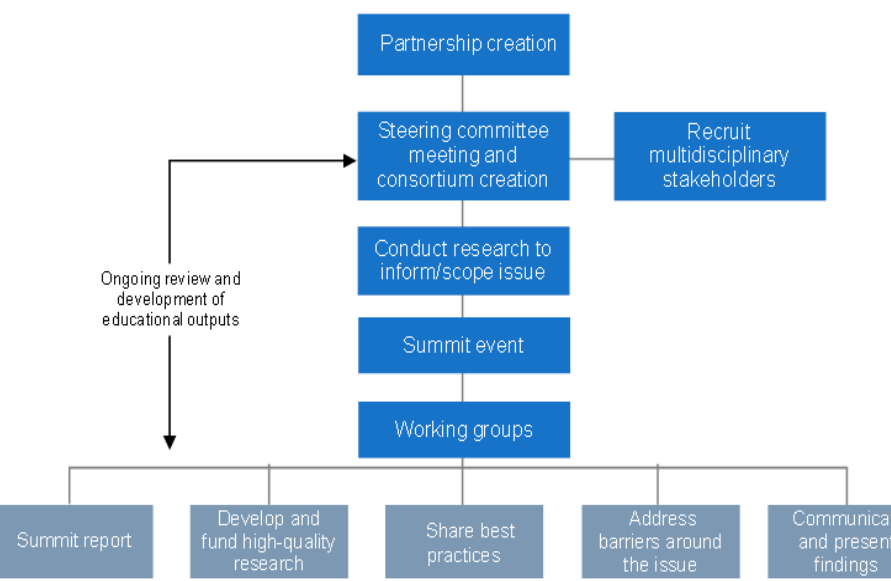
Figure 1. Key steps in development and implementation of a leadership